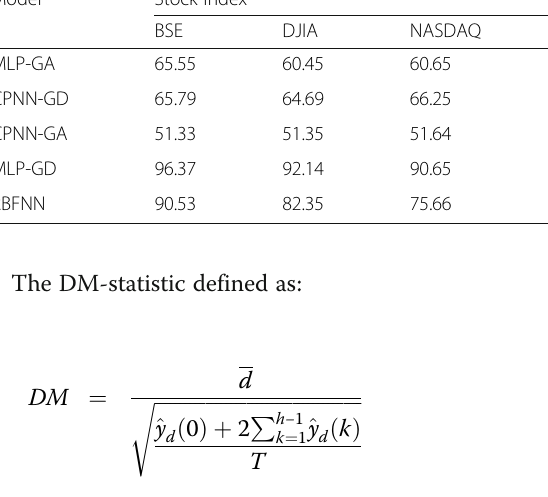
Table 4 Computation time from all models